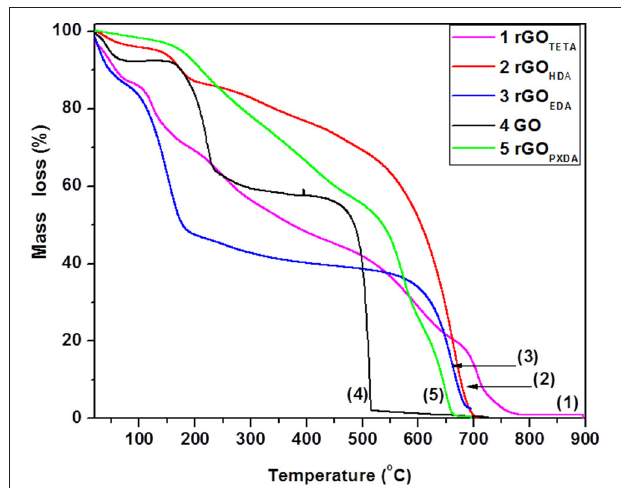
FIGURE 8 | TG analysis of aerogels with aliphatic diamines and GO.